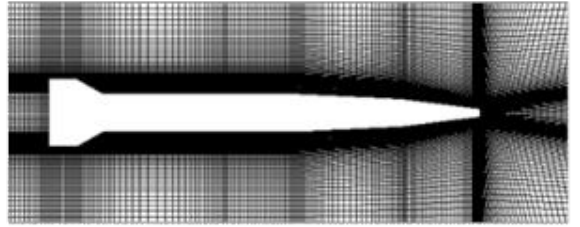
Figure 3. Grids around the vehicle.